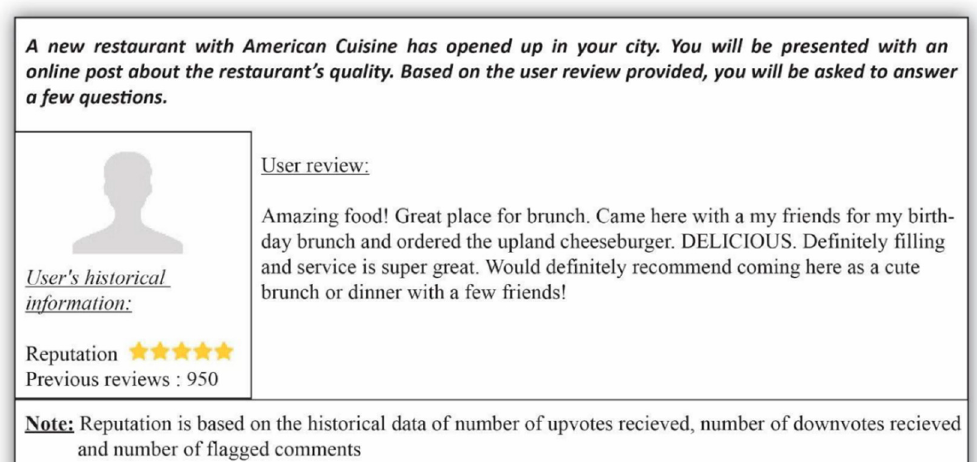
Figure 3. Anonymous and supporting user review of a restaurant with no reaction, high reputation and high number of previous reviews.